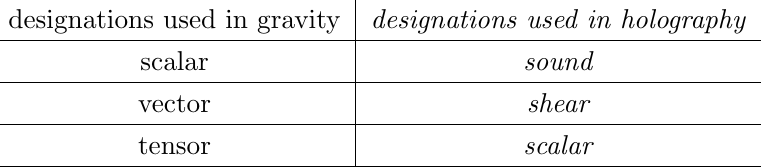
Table 1 . Terms used for types of gravitational perturbations in AdS/CFT- and gravity-oriented